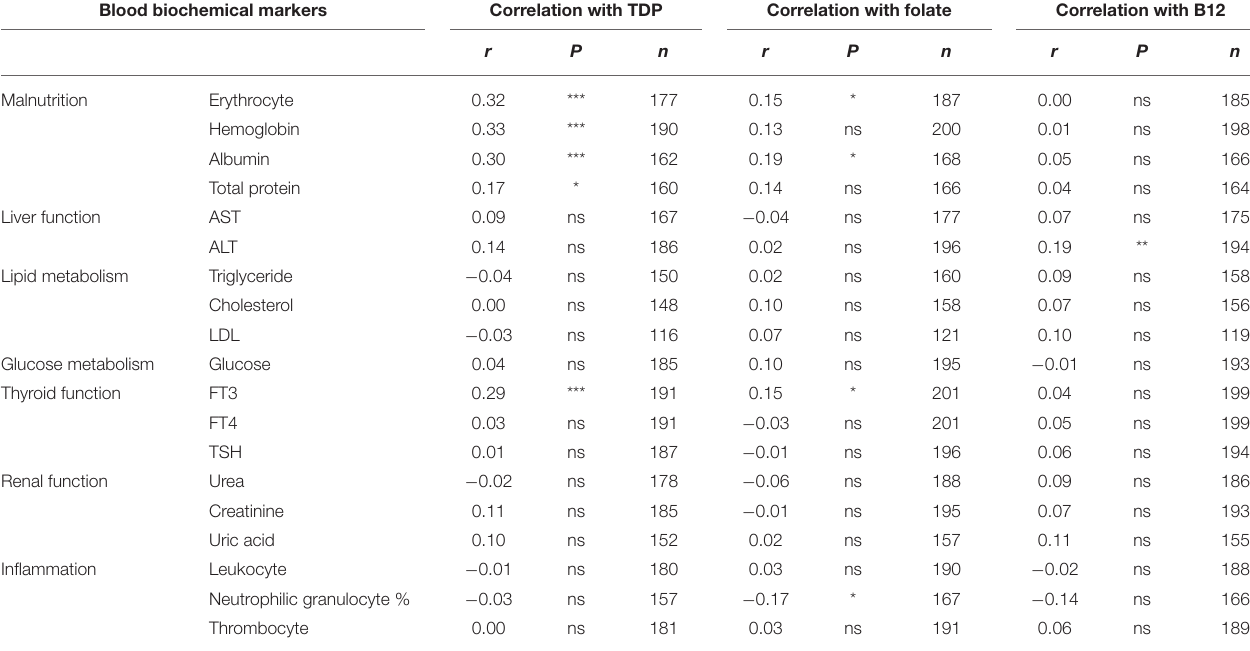
TABLE 3 | Association between B vitamins status and biochemical indicators in AD patients. Blood biochemical markers Correlation with TDP Correlation with folate Correlation with B12